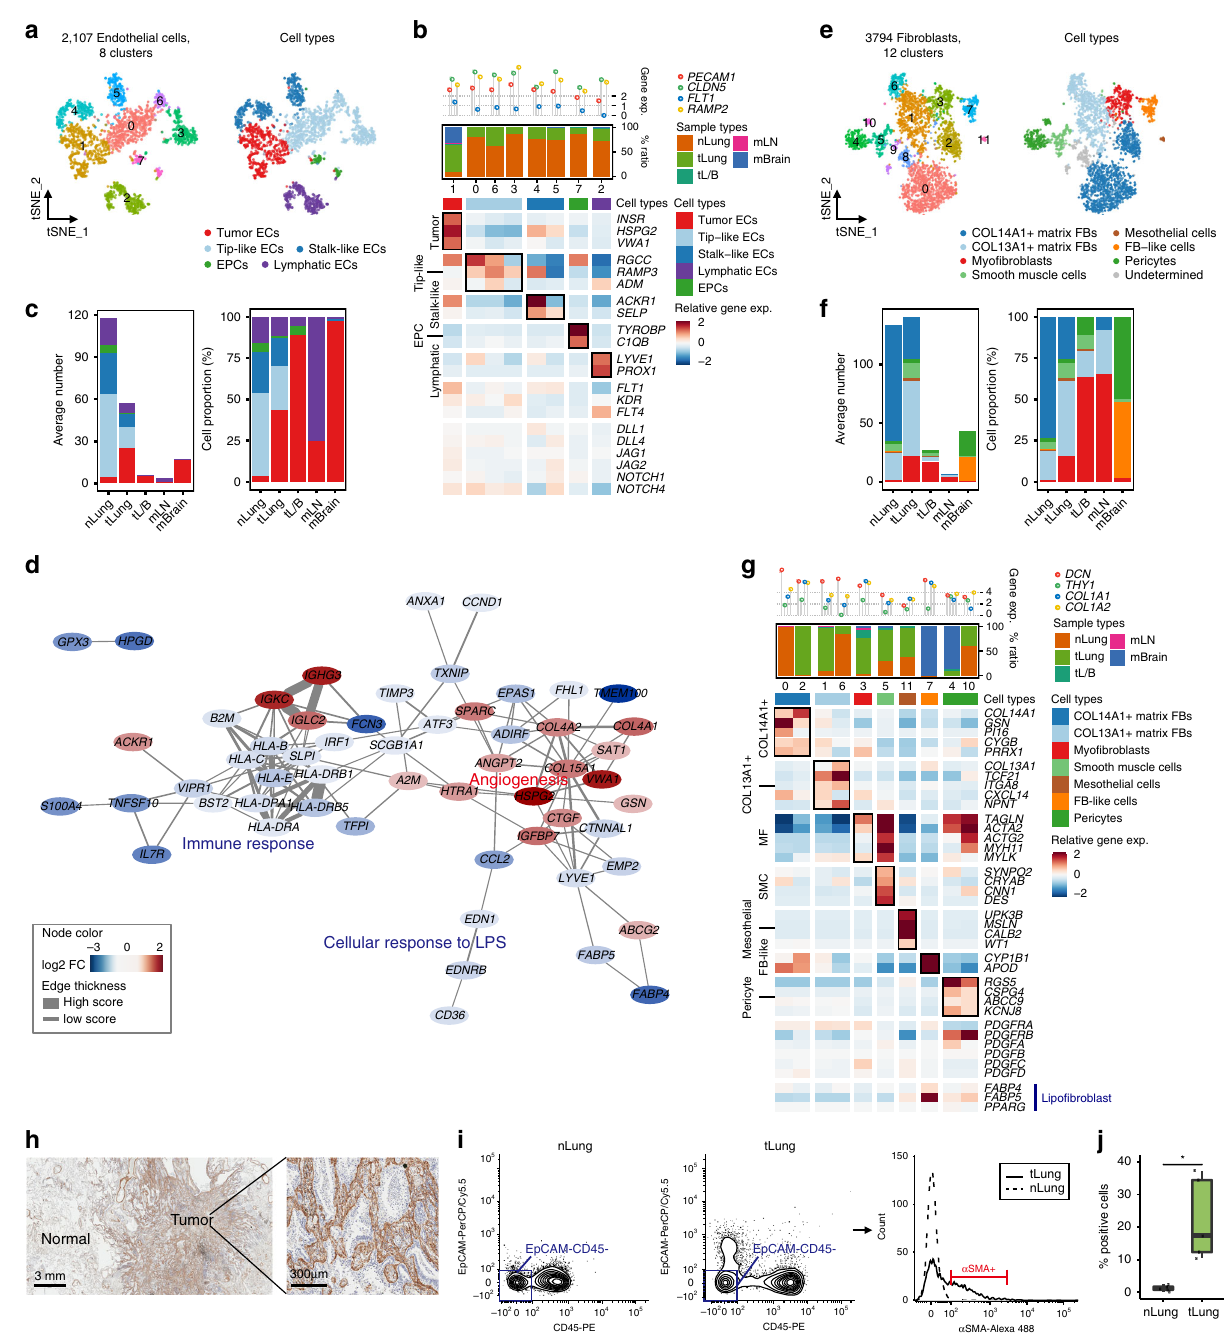
Fig. 3 Tumor endothelial cells and myo fi broblasts promoting angiogenesis and tissue remodeling. a tSNE plot of endothelial cells, color-coded by clusters and cell subsets as indicated. EPCs: endothelial progenitor cells. b Three-layered complex heatmap of selected endothelial cell marker genes in each cell cluster. Top: Mean expression of known lineage markers. Middle: Tissue preference of each cluster; Bottom: Relative expression map of known marker genes associated with each cell subset. Mean expression values are scaled by mean-centering, and transformed to a scale from -2 to 2. c Average cell number and relative proportion of EC subsets from tissues of each origin. nLung, n = 11 samples; tLung, n = 11 samples; tL/B, n = 3 samples; mLN, n = 2 samples; mBrain, n = 9 samples. d Functional association networks between signature genes speci fi c to tumor ECs. e tSNE plot of fi broblasts (FBs), color- coded by clusters and cell subsets as indicated. f Average cell number and relative proportion of fi broblast subsets from tissues of each origin (excluding undetermined cells). nLung, n = 11 samples; tLung, n = 11 samples; tL/B, n = 3 samples; mLN, n = 4 samples; mBrain, n = 10 samples. g Complex heatmap of selected fi broblast marker genes in each cell cluster, as shown in ( b ) (excluding undetermined cells). h , IHC staining of α -SMA on formalin- fi xed and paraf fi n-embedded slides for the independent biospecimens ( n = 4). All replicates showed the similar results. i , Representative fl ow cytometry plots showing myo fi broblast ( α -SMA + ) in primary tumor (T06) and normal lung (N06) tissues. j , Box plot of the percentage of myo fi broblast ( α -SMA + ) in normal and tumor-derived EPCAM − CD45 − cells. nLung ( n = 5; N06, N18, N41, N42, N43) and tLung ( n = 5; T06, T18, T41, T42, T43). SMC and pericytes can be included in the α -SMA + cells as minor populations. * p < 0.05 ( p = 0.02), two-sided Student ’ s t test. Each box represents the interquartile range (IQR, the range between the 25th and 75th percentile) with the mid-point of the data, whiskers indicate the upper and lower value within 1.5 times the